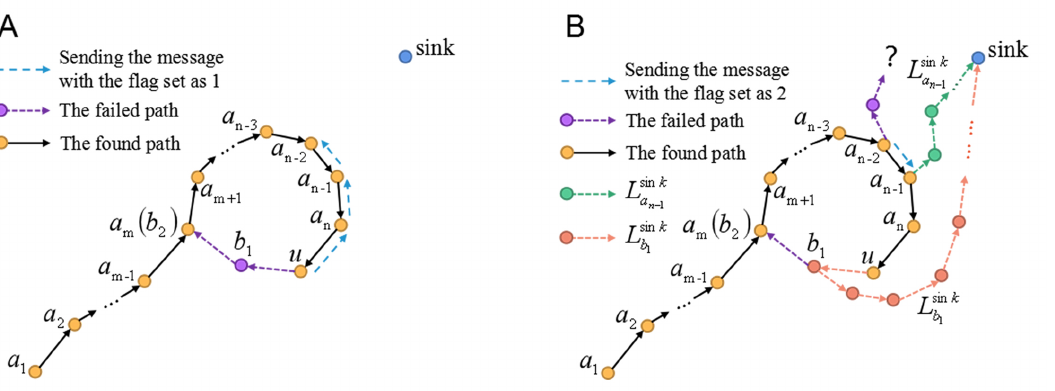
Figure 8. ( A ) The current forwarder u finds that if it chooses node b 2 as the next 2-hop node (as shown by the purple dotted line), there will be a routing loop −−−−−−−−−−−−→ . Then, u selects the a m a m + 1 ··· a n ub 1 a m ( b 2 ) node a n − 1 with the smallest distance to the sink from its neighbors a n − 1 , a n , u , b 1 , and b 2 . After that, as shown by the blue dotted line, u sends a message packet to a n − 1 to inform a n − 1 to select the node nearest to the sink from the neighbors. In this way, we can acquire the node a n − 2 which is nearest to the sink on the found path. ( B ) If a n − 2 could not find any new next 2-hop node to break the loop, a n − 2 will send the message packet with the flag set as 2 to a n − 1 (as shown by the blue dotted line). a n − 1 is nearest to the sink among the neighbors of a n − 2 . Then, a n − 1 selects the new next 2-hop node. The green dotted line denotes the new path explored by a n − 1